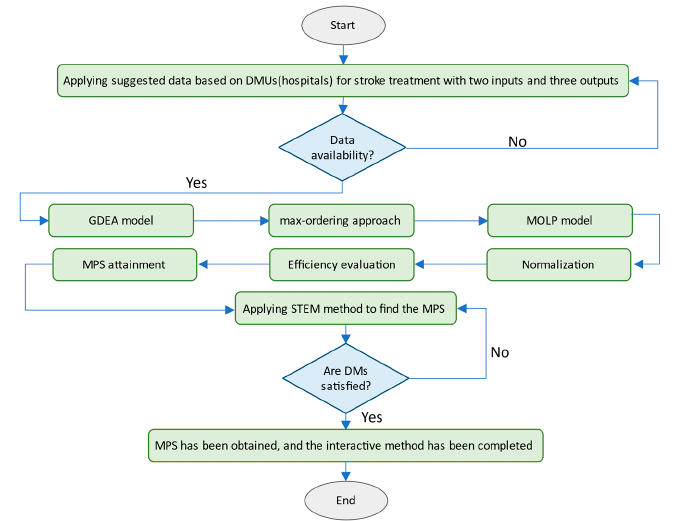
Figure 1. Flowchart of the proposed interactive model.